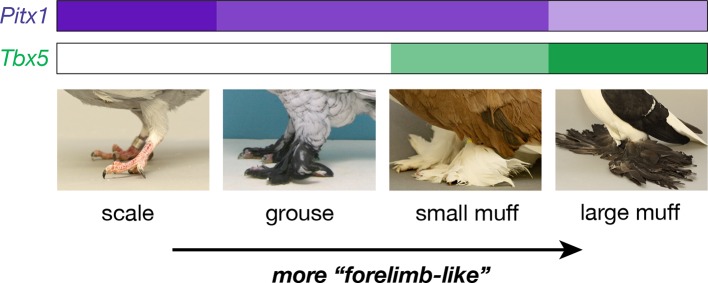
Model describing link between Pitx1 and Tbx5 expression levels and foot epidermal appendage morphology.Darker colors indicate higher expression levels. Decreased expression of Pitx1 and ectopic expression of Tbx5 are associated with foot feathering (and other morphological transformations) in domestic pigeons.